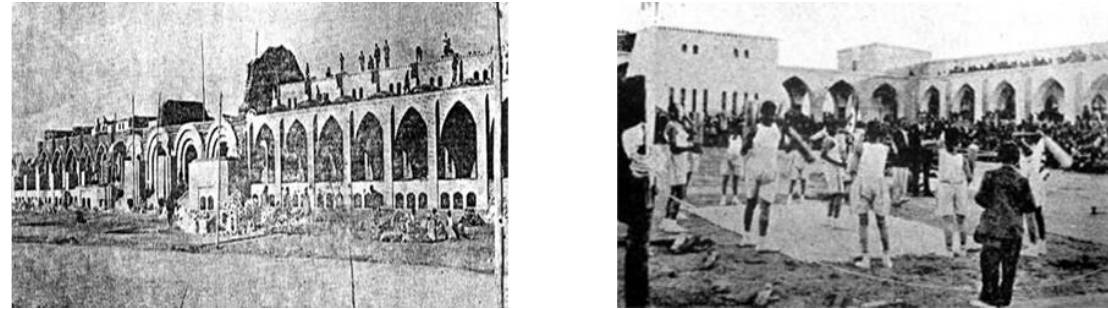
Figure 8 The Iranshahr School by Andre Godard and Maxim Siro